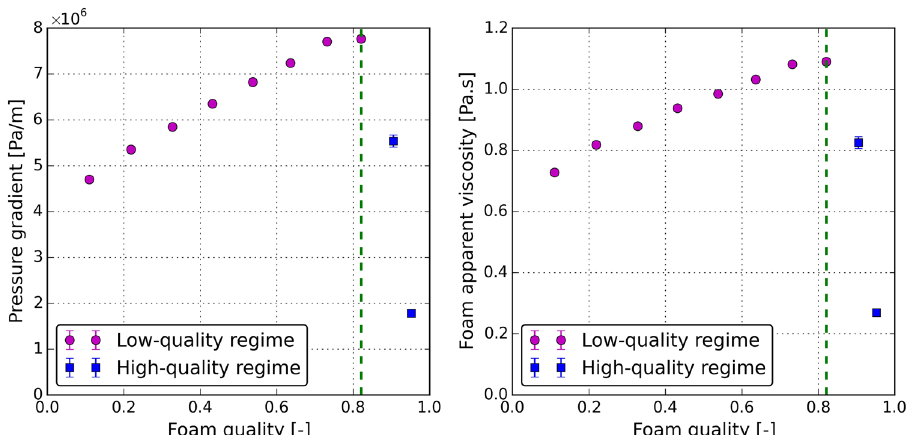
Figure 2. ( a ) The pressure gradient along the core and ( b ) the calculated apparent viscosity at different fractional flows of nitrogen. The total flowrate was set to a constant value of 1 ml/min. Purple circles and blue squares show the low- and high-quality regimes, respectively. The vertical green dashed line separates the low- and the high-quality regimes.